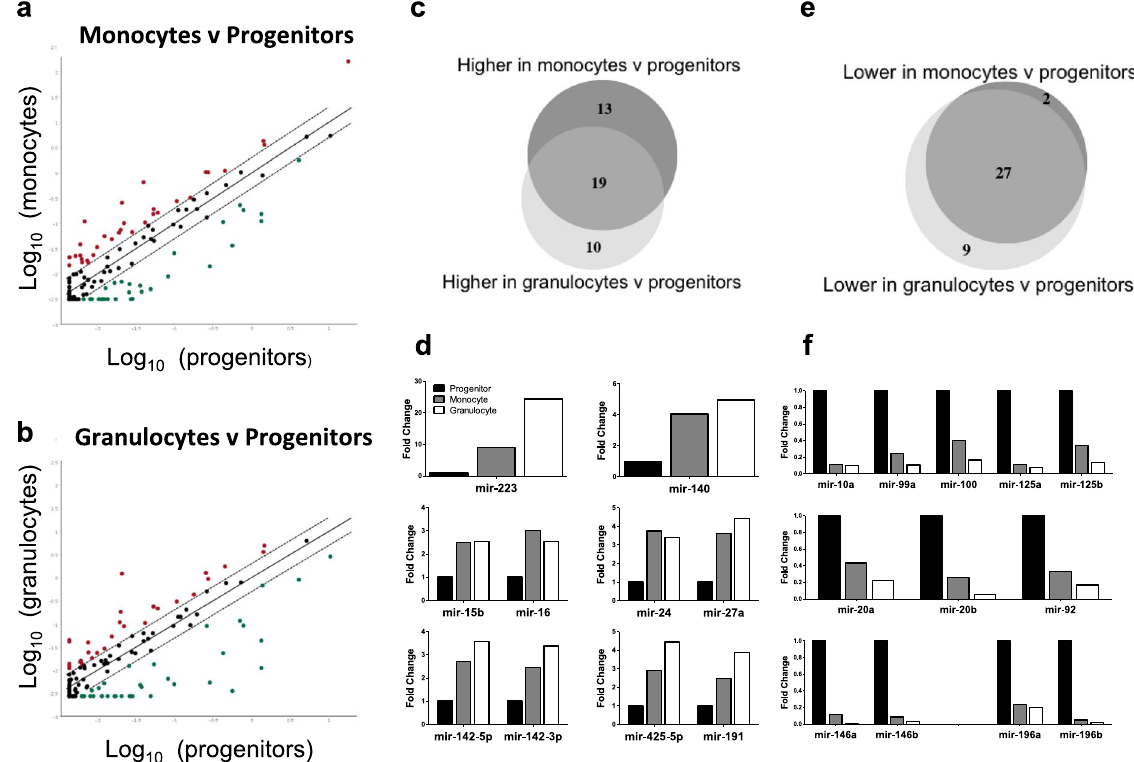
Figure 2. MiRNA profiling of cord blood myeloid progenitors, monocytes and neutrophils. Normalised TaqMan Low-Density Array (TLDA) profiles of miRNA expression in ( a ) monocytes vs. myeloid progenitors and ( b ) granulocytes vs. myeloid progenitors from human cord blood. MiRNAs with ≥ 2-fold increased expression in the mature cell types are shown in red and those with ≥ 2-fold decreased expression are shown in green. ( c ) Number of miRNAs increased ≥ 2-fold or more in each comparison. ( d ) Top panel: miRNAs with a ≥ 2-fold increase in both cell types. Middle and lower panel: miRNAs that are increased in both cell types and are clustered together in the genome. ( e ) Number of miRNAs decreased ≥ 2-fold in each comparison. ( f ) Top panel: the five miRNAs of the same family (highly similar seeds) that are decreased in both mature cell types relative to the progenitor. Middle and lower panels: miRNAs that decreased in both comparisons and are clustered together in the